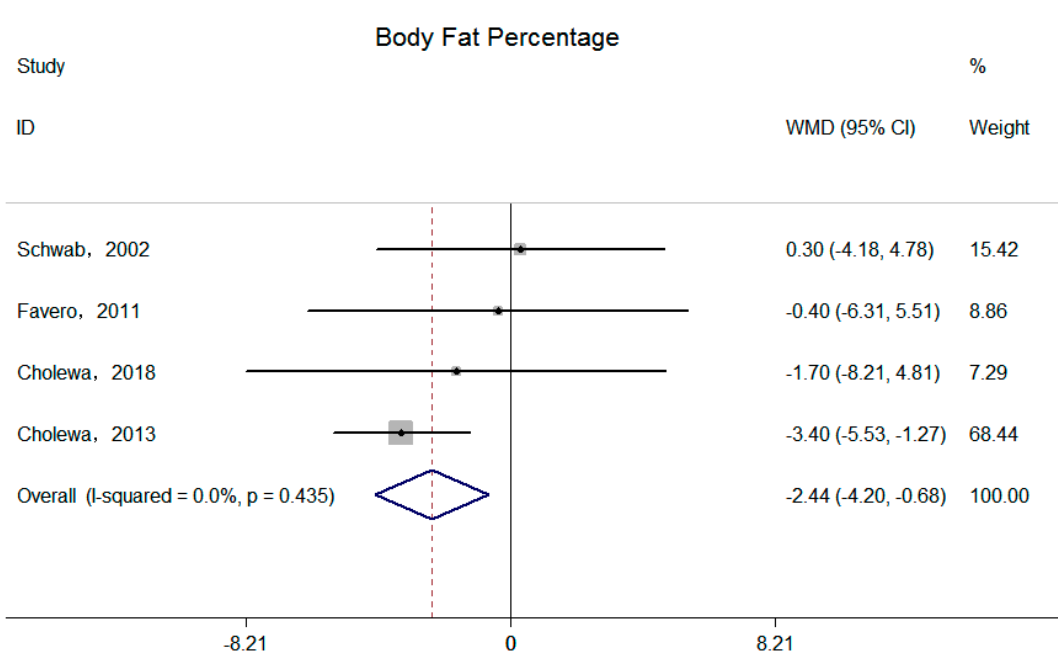
Figure 5. E ff ects of supplemental betaine on body fat percentage in participants. The pooled e ff ect was Figure 5. Effects of supplemental betaine on body fat percentage in participants. The calculated by using a random-e ff ects model. The diamonds denote the summary risk estimate, and the pooled effect was calculated by using a random-effects model. The diamonds denote the horizontal lines represent the 95% CI. summary risk estimate, and the horizontal lines represent the 95% CI.